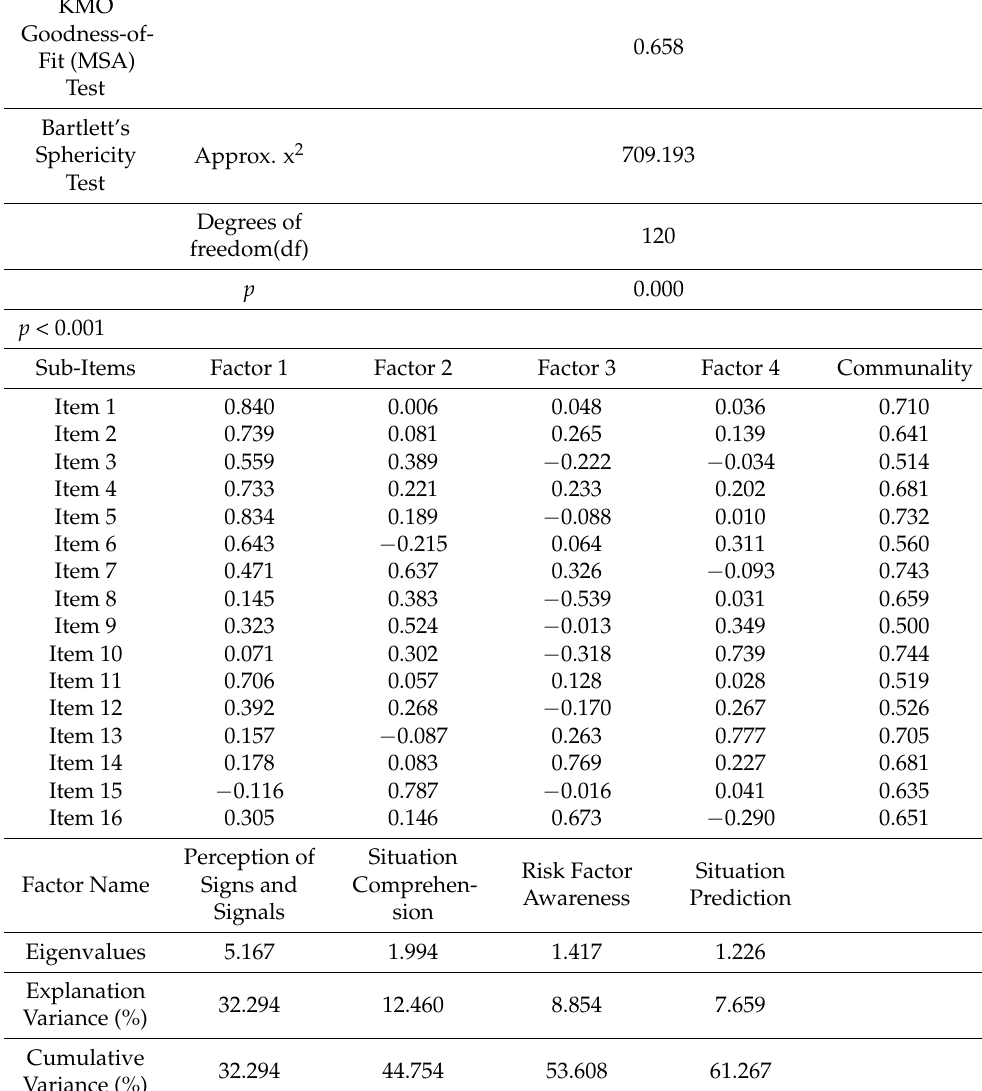
Table 3. Exploratory factor analysis for web-based MDSST ( n =